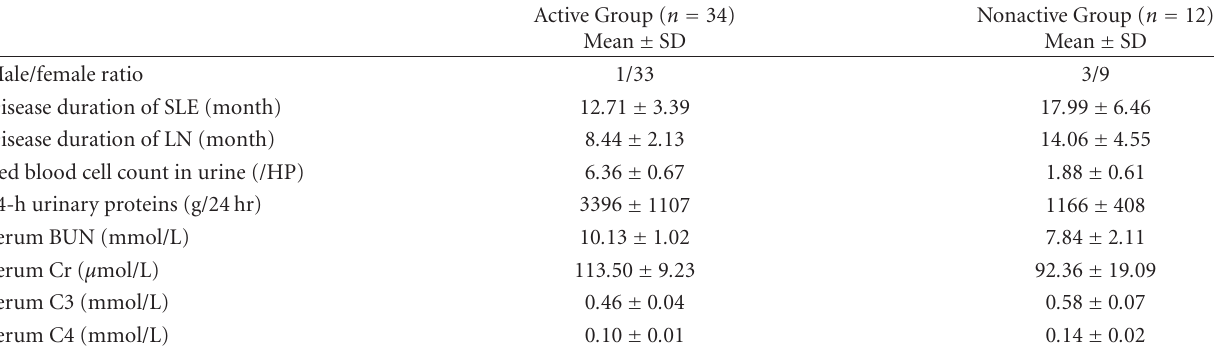
Table 1: Comparison between active group and nonactive group in terms of important clinical and laboratory findings.